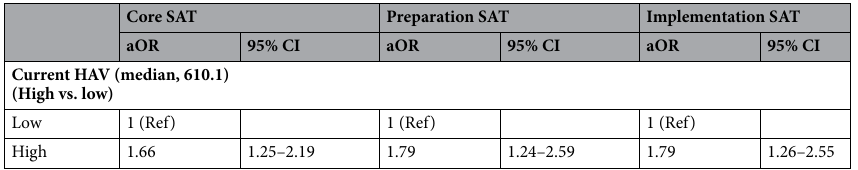
Table 4. Associations of current health asset value with health management strategies, adjusted for age, sex, income, and comorbidity ( n = 1000), multiple stepwise model*. HAV health asset value, aOR adjusted odds ratios, CI confidence interval, Ref reference, SAT Smart Management Strategy for Health (SMASH) Assessment Tool. *Multiple stepwise logistic regression models selected significant variables with p-value of stay = 0.05, leave = 0.05, adjusted with age (≤ 50 vs. > 50), sex (male vs. female), household monthly income (< 3000$ vs. 3000$ ≤), and comorbidity (no vs. yes).